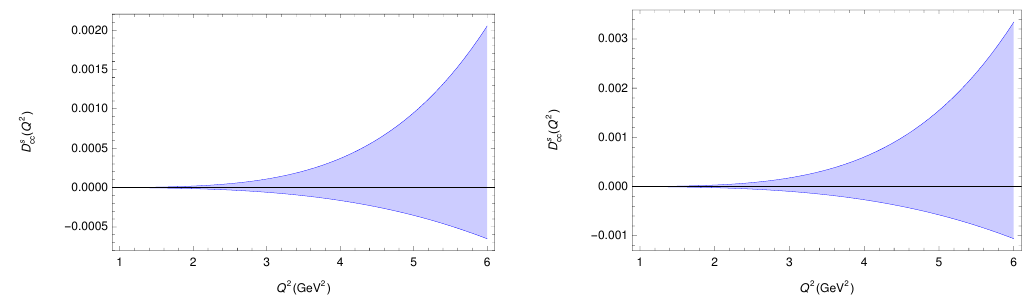
( Q 2 ) for α ( n f =5) s ( M 2